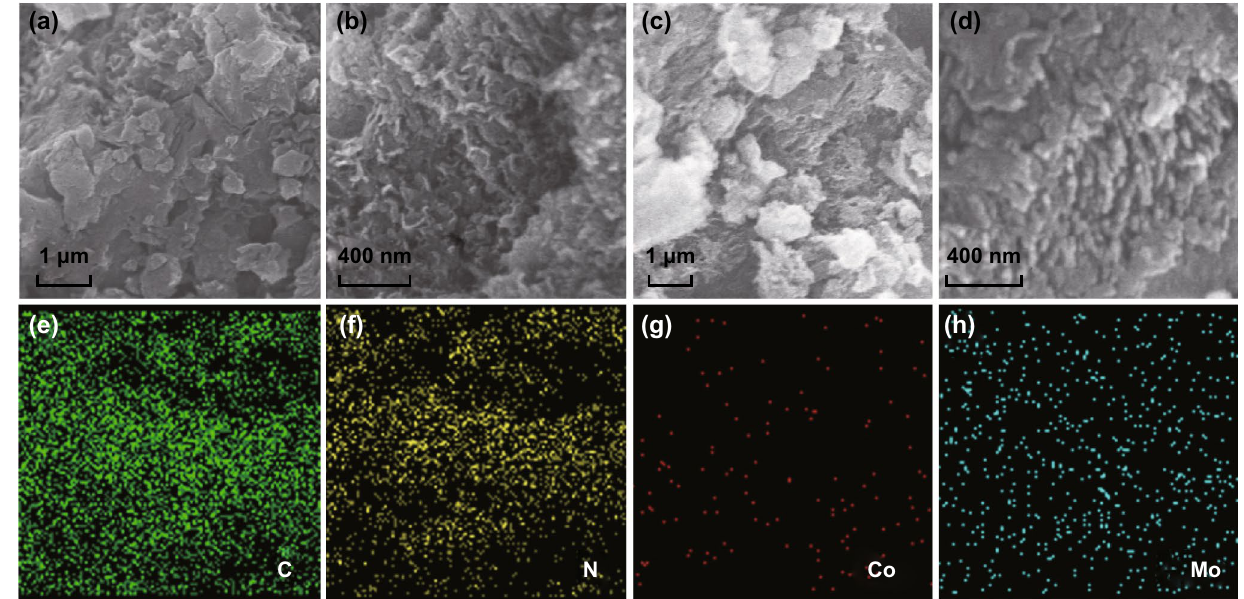
Fig. 4 SEM images of a P-CN, b Co-CN-5, c Mo-MCN-2, d Co/Mo-MCN-5, e–h elemental mapping for